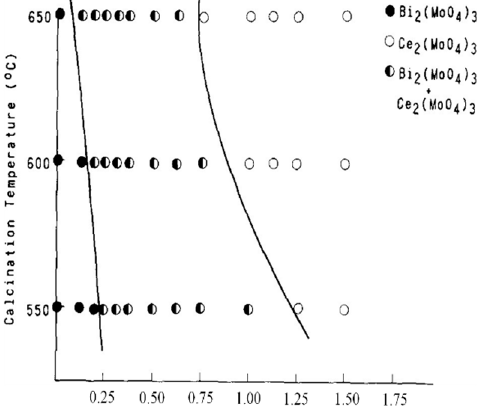
Figure 5. Partial phase diagram of Bi 1-x Ce x Mo 3 O 12 where x is shown on the x-axis. Source with per- mission